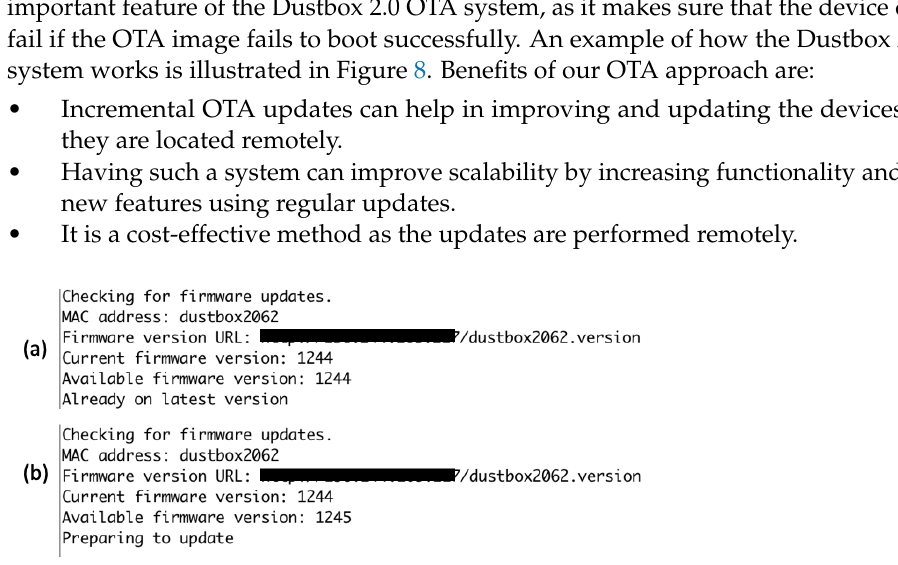
Figure 8. Examples of OTA functions: ( a ) no update available; and ( b ) firmware update is